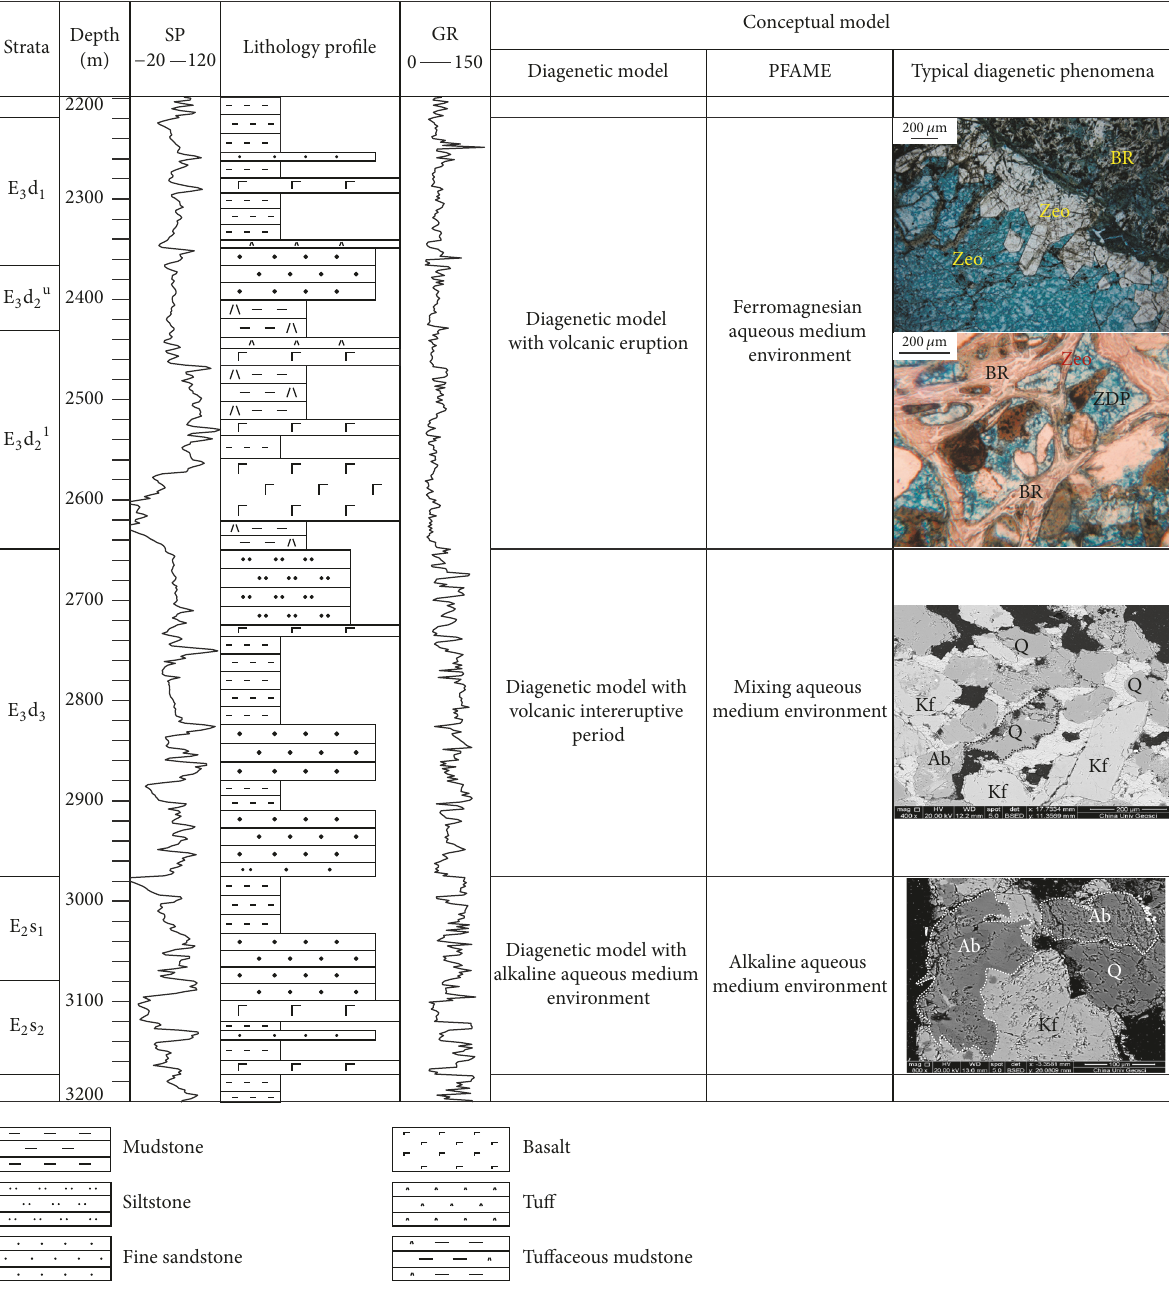
Figure 10: Vertical evolution of pore fluids properties and typical diagenetic phenomena of well BZ-1, Huanghekou Sag. Ab = albitization, BR = basalt rock fragment, Kf = K-feldspar, PFAME = pore fluid aqueous medium environment, Q = quartz, ZDP = zeolite dissolution pore, and Zeo =